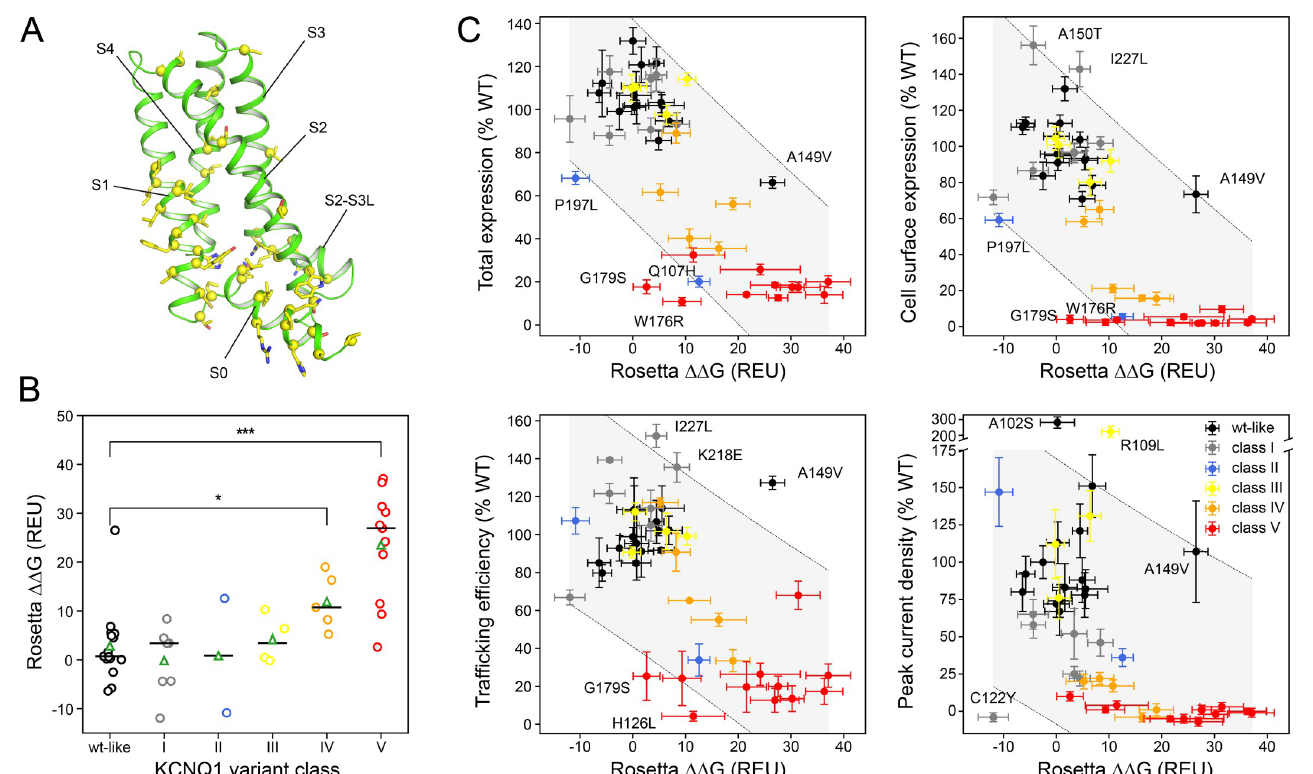
Fig 7. Computationally predicted stability changes of KCNQ1 variants with mutations in the VSD. ( A ) Location of mutation sites in the KCNQ1 VSD. Backbone sites are mapped by yellow spheres and the native amino acid residue is indicated by yellow sticks. ( B ) Distribution of Rosetta ΔΔ G values for the six functionally distinct classes of KCNQ1 VSD variants [19] (i.e. WT-like and classes I to V for non-functional variants) calculated with the AO homology model. The median and average values are drawn as a black horizontal line and a green triangle, respectively. The median of class IV and V is compared to that one of WT-like variants using a Kruskal-Wallis H-test ( � p < 0.05, �� p < 0.01, ��� p < 0.001, n WT-like = 15, n IV = 5, n V = 11). ΔΔ G values for mutations to proline are off-scale ( ΔΔ